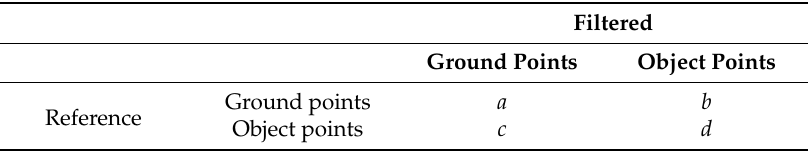
Table 2. Cross-matrix of filtering result.